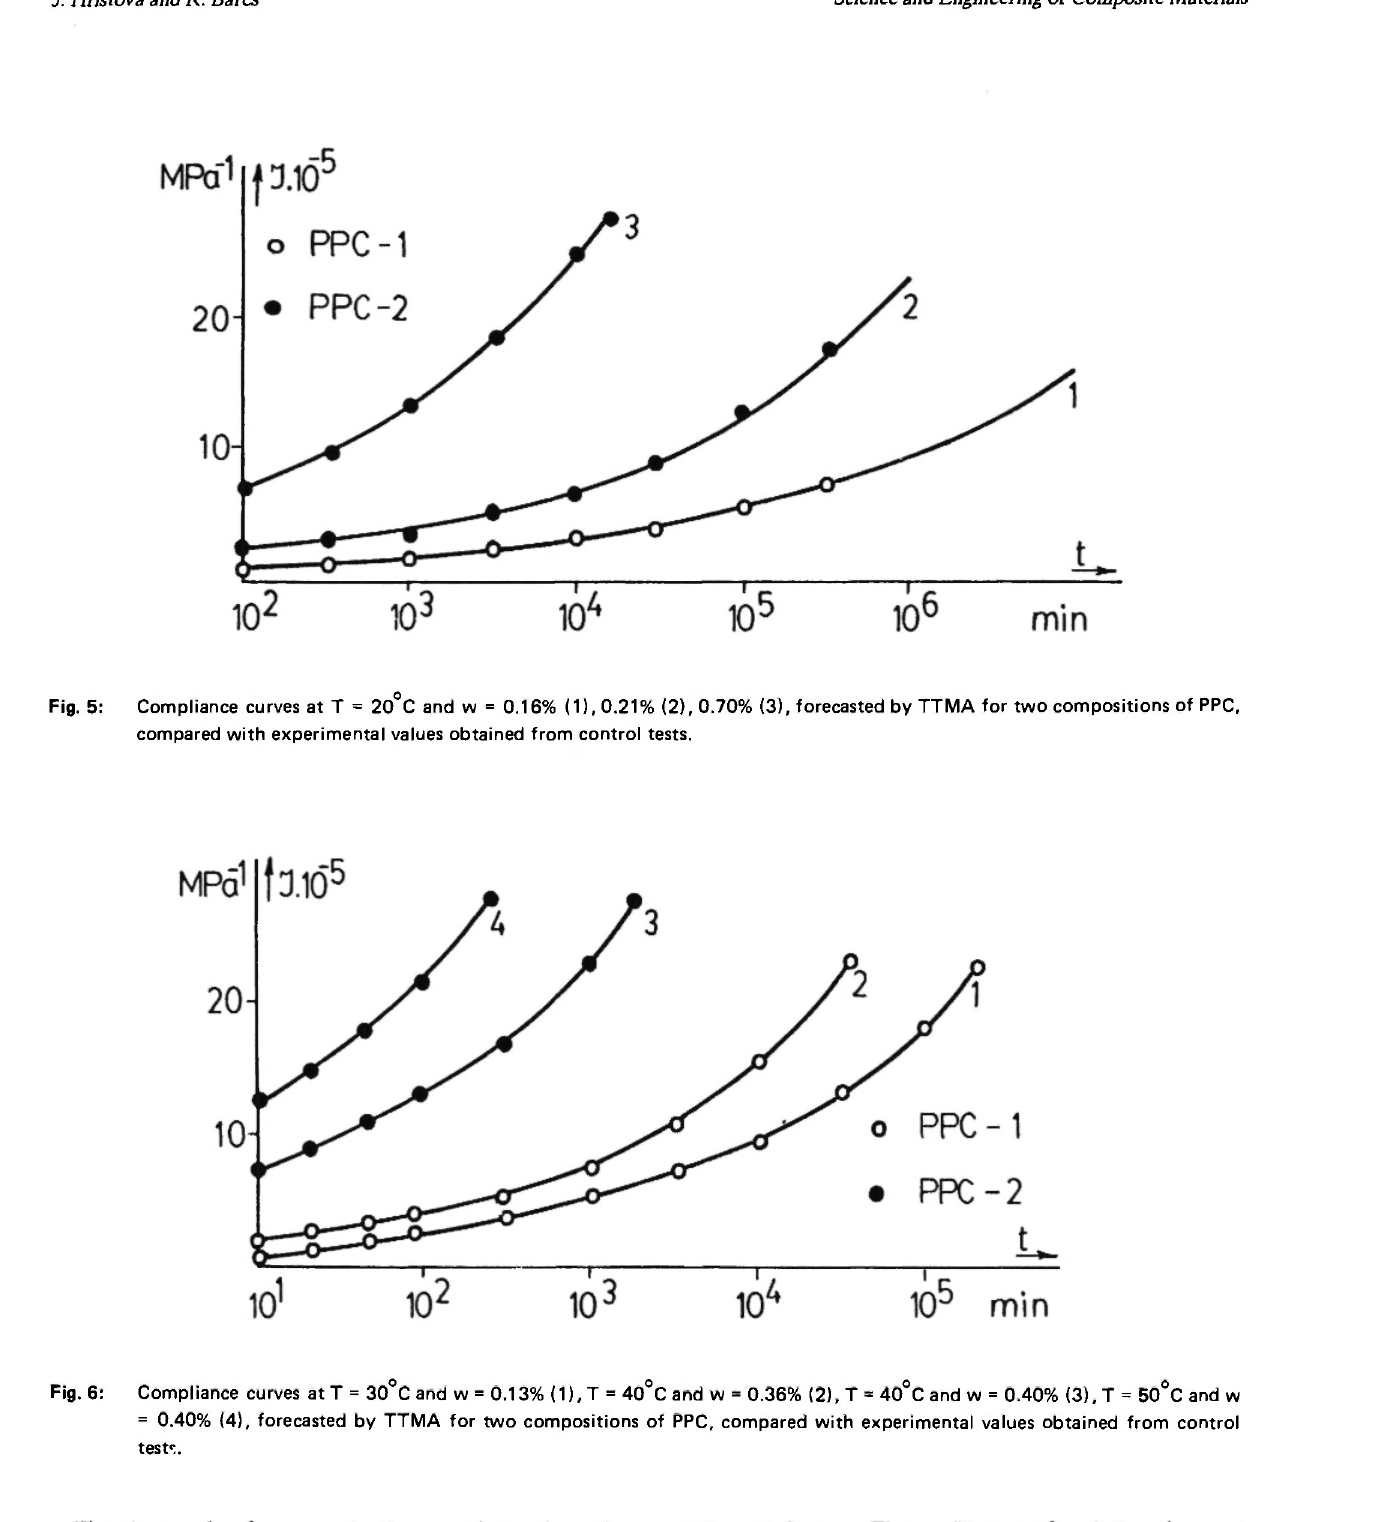
Fig. 6: Compliance curves at Τ = 30°C and w = 0.13% (1),T = 40°C and w = 0.36% (2), Τ = 40°C and w = 0.40% (3), Τ = 50°C and w = 0.40% (4), forecasted by TTMA for two compositions of PPC, compared with experimental values obtained from control